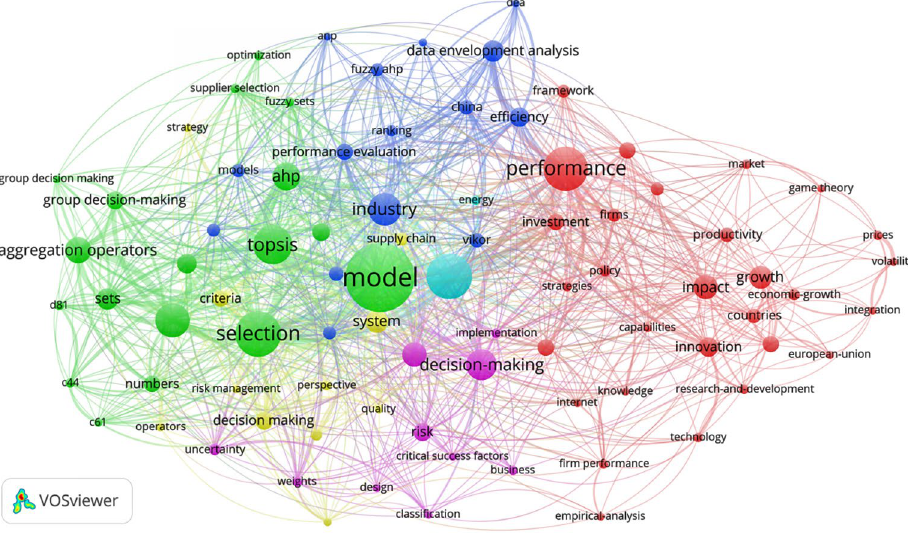
Figure 5. Co-occurrence network of keywords of the TEDE publications,